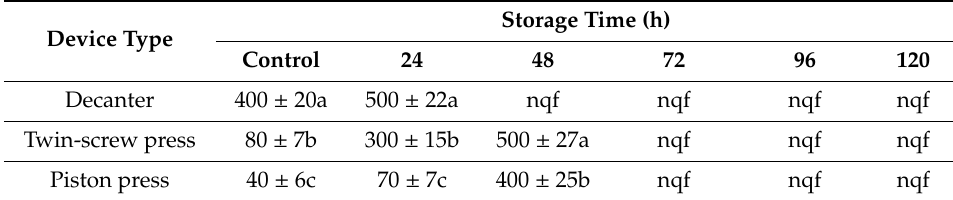
Table 2. Total number of mesophilic microorganisms (cfu / mL) in apple juice obtained with various devices stored at 20 ◦ C. Di ff erent letters in the same column indicate values significantly di ff erent at P <